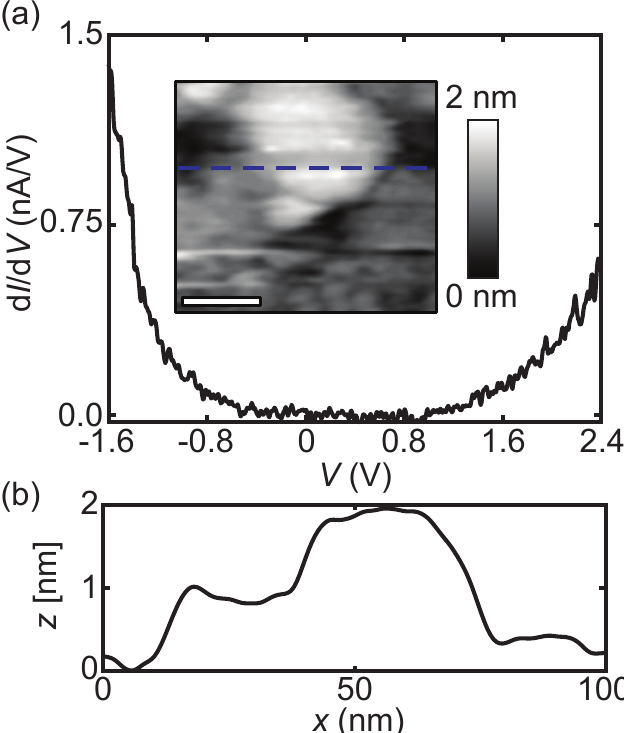
( V ) ) on the 16-unit-cell-thick BBO film on Nb:STO(001). Figure 2. Differential conductivity spectra ( d I d V A band gap of approximately 1.2 ± 0.3 eV is observed. Inset: Topography image (100 × 100 nm, scale bar 30 nm). The tunneling parameters are 500 pA and − 1.8 V. ( b ) Cross-sectional height profile of the corresponding blue dashed line in the inset of ( a